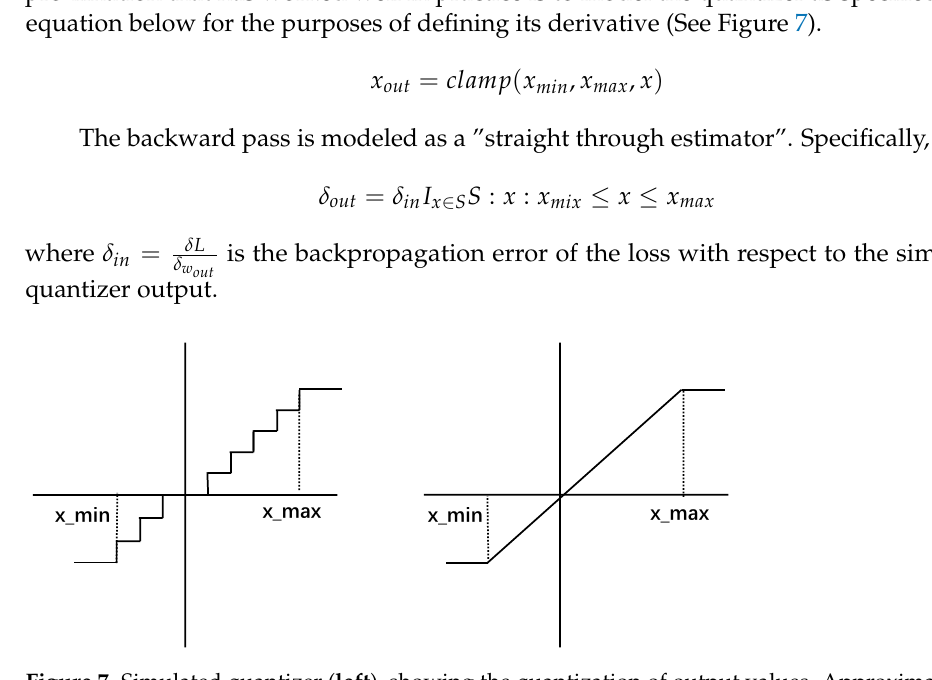
Figure 7. Simulated quantizer ( left ), showing the quantization of output values. Approximation for the purposes of the derivative calculation ( right